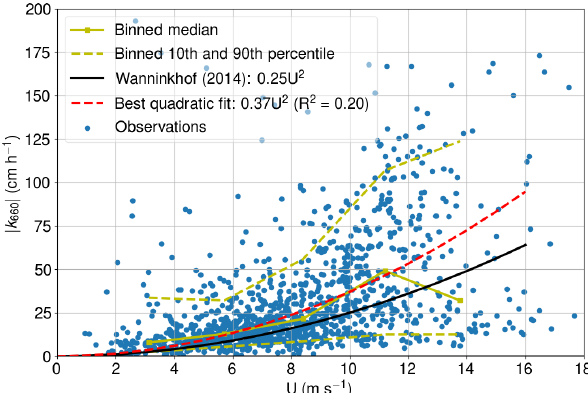
Figure A1. Absolute gas transfer velocity as a function of wind